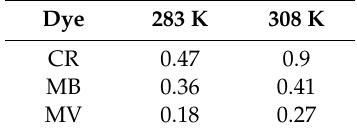
Table 4. Pseudo-first-order adsorption rate constants calculated